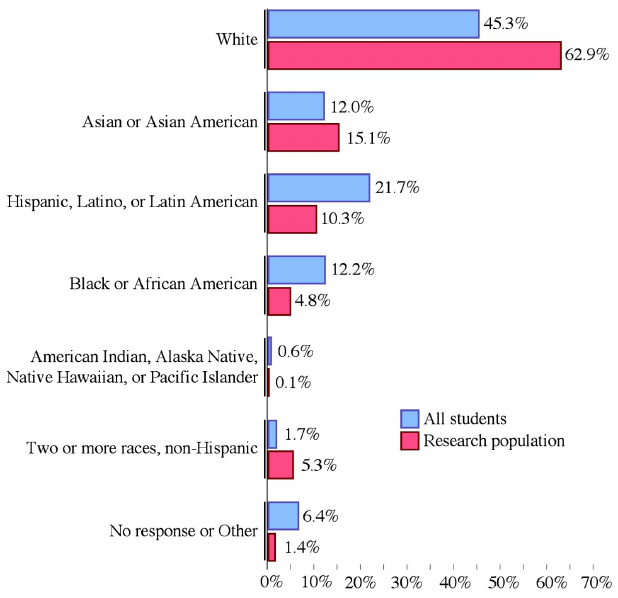
FIG. 5. Comparison of racial or ethnic distributions of all students taking the SAT in 2015 versus the PER research population from our study. Data and category titles are taken from the College Board